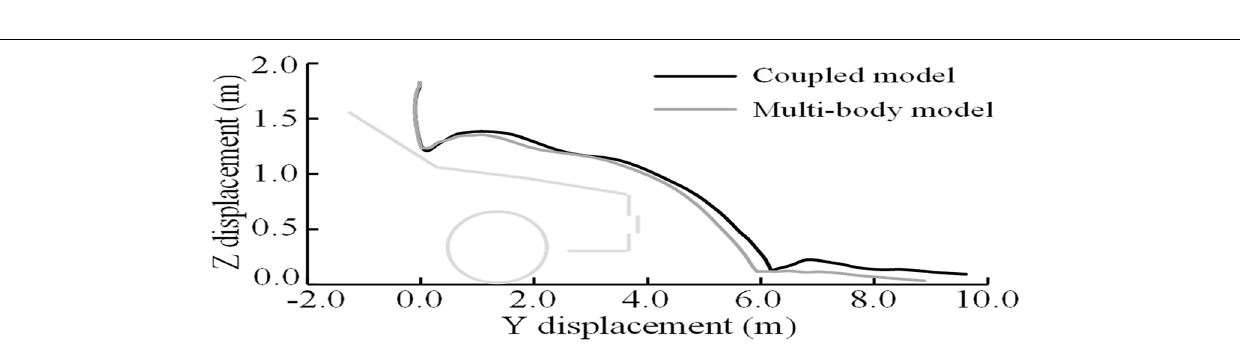
FIGURE 8 | Predicted pedestrian kinematics and the comparison of vehicle deformation between accident reconstruction and real accident, with Case 1 as the example.